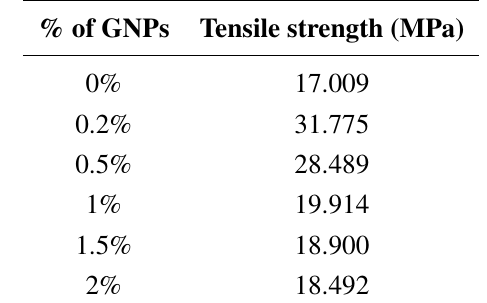
Table 1. Dependence of the tensile strength on the filler ratio of graphene nanoplatelets